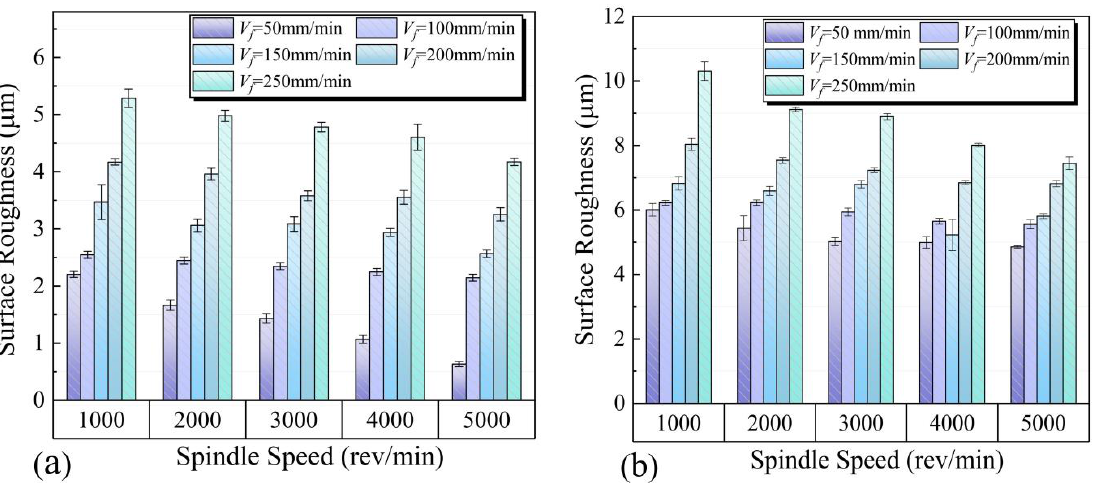
14 of 18 Figure 9. Chip accumulation in drilling of PTFE: ( a ) Chip accumulation phenomenon; ( b ) Sche- matic diagram of chip accumulation. 3.3. Effect of Drilling Parameters on Surface Roughness To illustrate the effect of drilling parameters, the variation of surface roughness near the hole entrance and hole exit with drilling parameters is shown in Figure 10. It can be seen in Figure 10 that the surface roughness of the hole entrance and hole exit decreases with the increase of spindle speed and increases with increasing feed speed. When the spindle speed is 5000 rev/min and the feed speed is 50 mm/min, the minimum surface